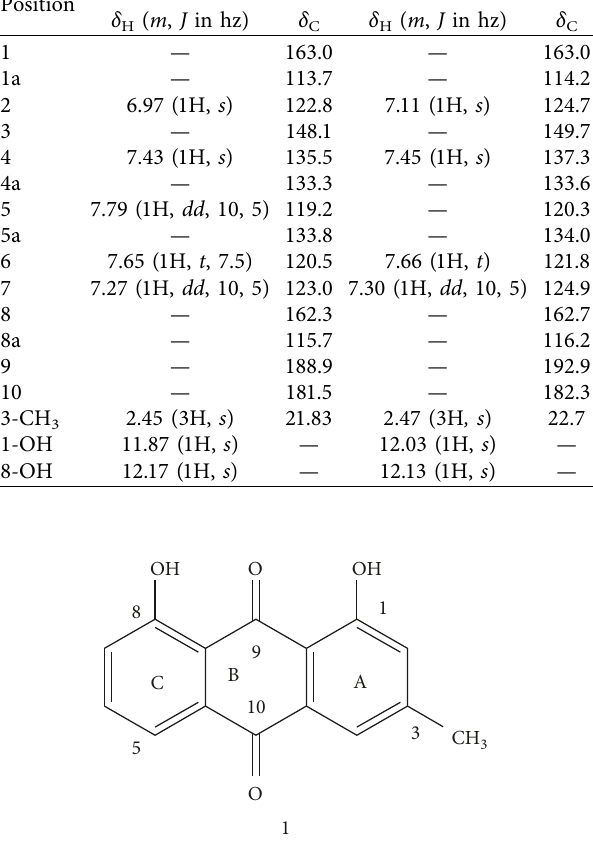
Figure 2: The structures of chrysophanol (1) are isolated from the root of K .